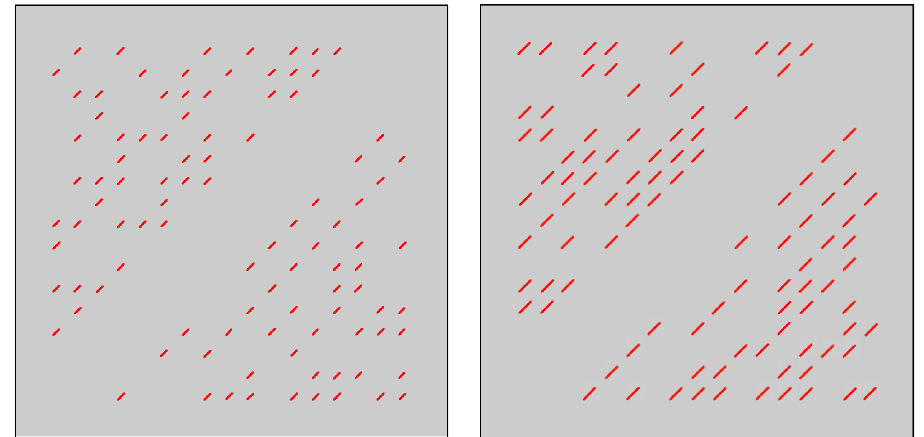
Figure 3. Geometry 1 and 2 with 100 straight fractures. Fractures γ are depicted in red color. Domain Ω = [ 0, L ] 2 is depicted in gray color with L = 500 m. Left: Geometry 1 with fractures length 10 m and 45 ◦ orientation angle. Right: Geometry 2 with fractures length 20 m and 45 ◦ orientation angle.